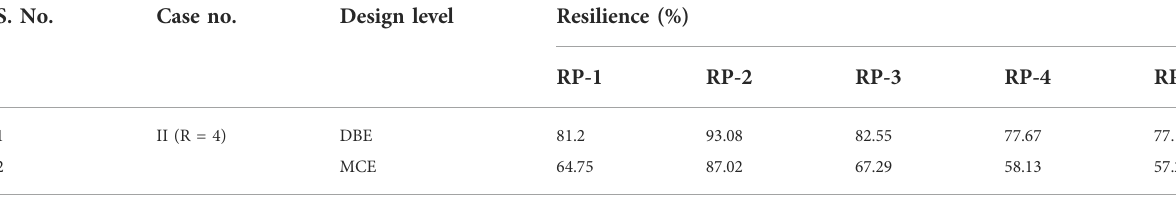
TABLE 10 Variation in resilience at each design level for case II building. S. No.